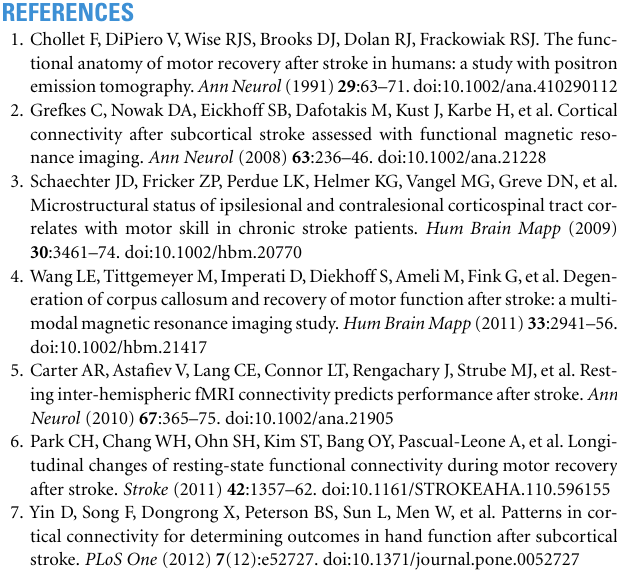
Table S1 | Regions where controls have greater FA than patients . Table S2 | Regions where patients have greater axial diffusivity (L1) than controls . Table S3 | Regions where patients have greater radial diffusivity (L2/L3) than controls . Figure S1 |Top row shows white matter regions where controls have greater fractional anisotropy (FA) than patients . Cluster numbers are indicated next to region and correspond to those listed inTable S1 in Supplementary Material. Second and third rows show white matter regions where patients have greater axial diffusivity (L1) than controls. Cluster numbers are indicated next to region and correspond to those listed inTable S2 in Supplementary Material. Rows four to six show white matter regions where patients have greater radial diffusivity (L2/L3) than controls. Cluster numbers are indicated next to region and correspond to those listed in S3. Images are taken in axial ( z ) or coronal ( y ) planes. All images show results that are significant at t >3.1, p <0.05 FWE using cluster